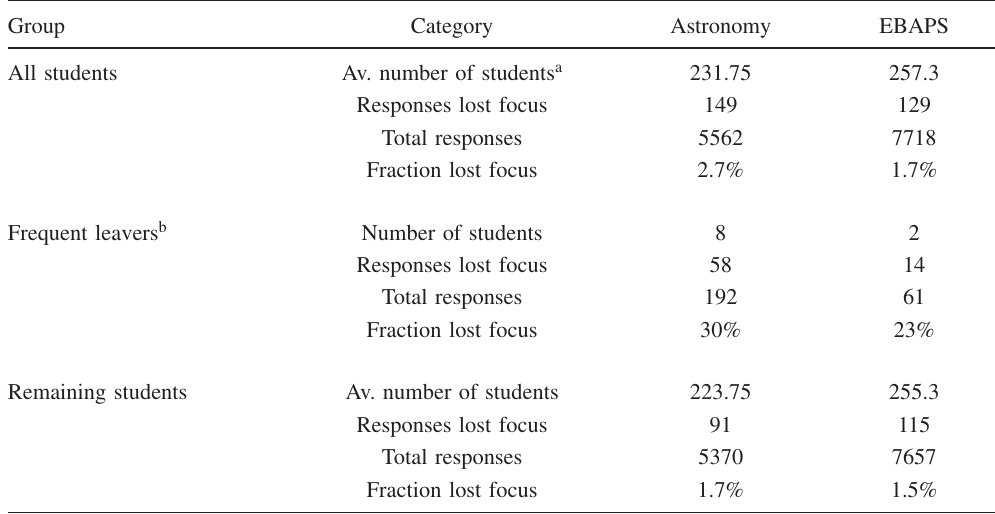
TABLE III. Summary of lost focus events on full-scale postcourse assessment. Most of the difference between the two assessments in how frequently a student leaves the browser window can be attributed to a small number of students who appear to have interacted with other applications